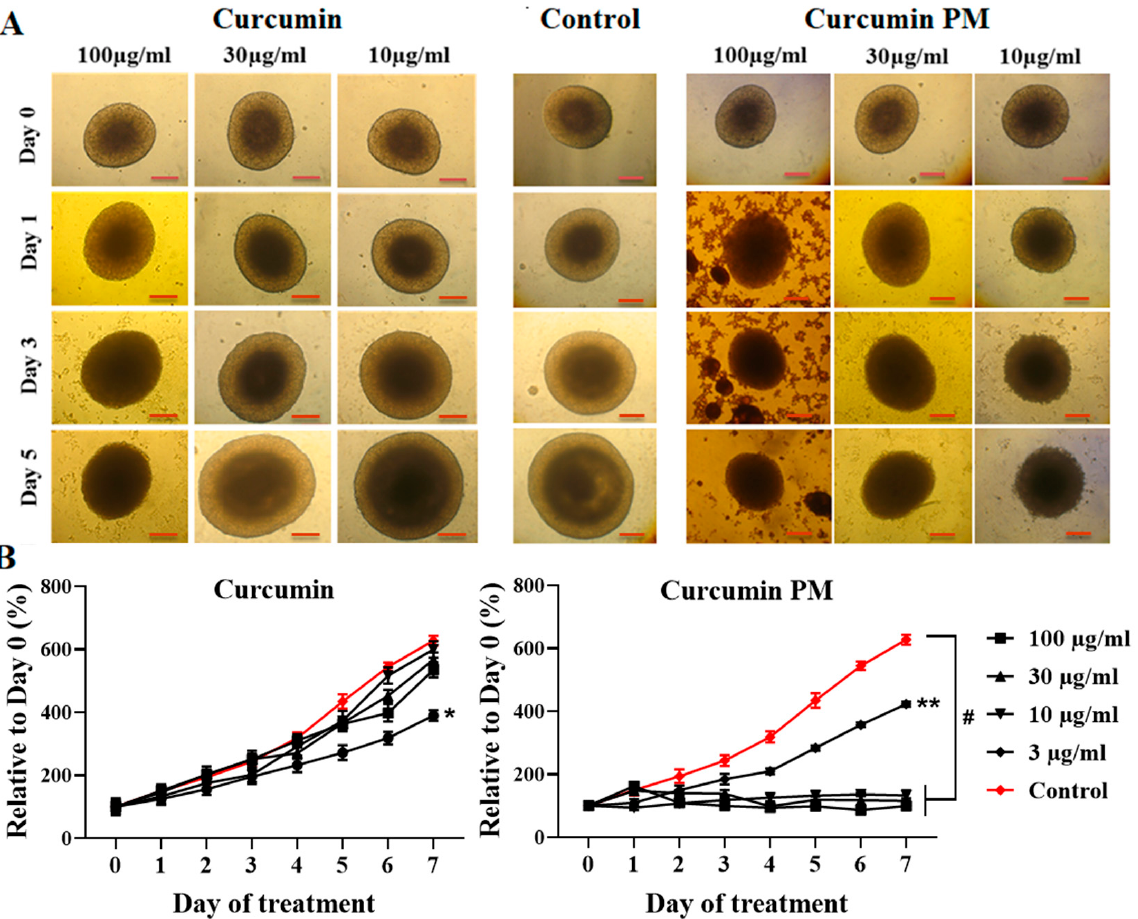
Figure 3. Curcumin PM successfully penetrated and inhibited the growth of MCF7 spheroids. ( A ) Morphology of spheroids of MCF7 cells incubated with either curcumin or nanocurcumin. The images were taken using an Axiovert 40CFL microscope (Zeiss, Germany) with a Canon Powershot G9 camera (Canon, Japan), and the diameters were analyzed by Axio version 4.5 (Zeiss, Germany). The scale bar represents 200 µm. ( B ) The growth curves of spheroids, when incubated with free curcumin and curcumin PM. The curves represented the dose-dependent behavior of MCF7 spheroids under two treatment conditions. The data are presented as mean ± SD, N = 3. * p < 0.05; ** p < 0.01; # p < 0.0001. Scale bar: 200 µm.